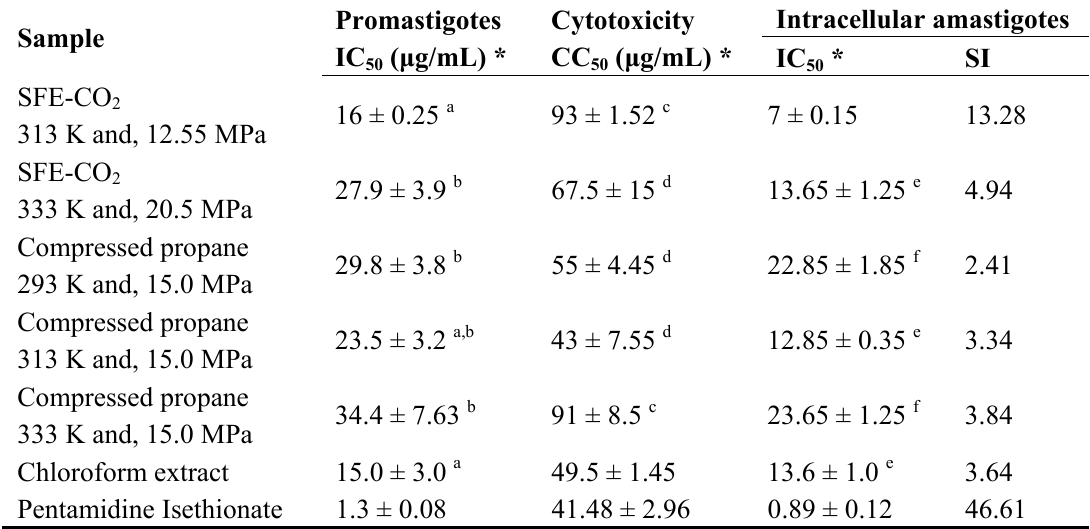
Table 3. Antipromastigote and anti-amastigote activity, cytotoxicity to the J774A1 macrophages, and SI of the extracts of P. amalago L. leaves and pentamidine isethionate (reference